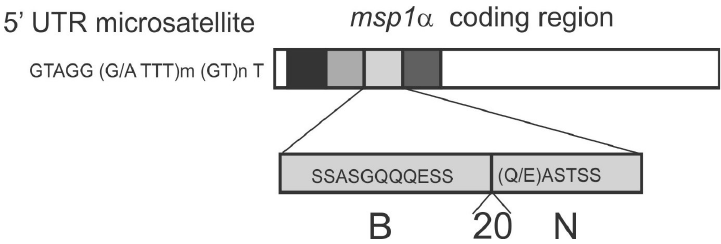
Figure 2. A schematic diagram of the msp1 α gene. The tandem repeats are shown as grey boxes, with each shade representing a different repeat. The microsatellites in the 5' untranslated region (UTR) used in a second genotyping system are shown. The B-cell (B) and neutralization sensitive (N) epitopes, and amino acid 20, found to be important for binding to tick cell extracts, are shown on an enlarged protein repeat.